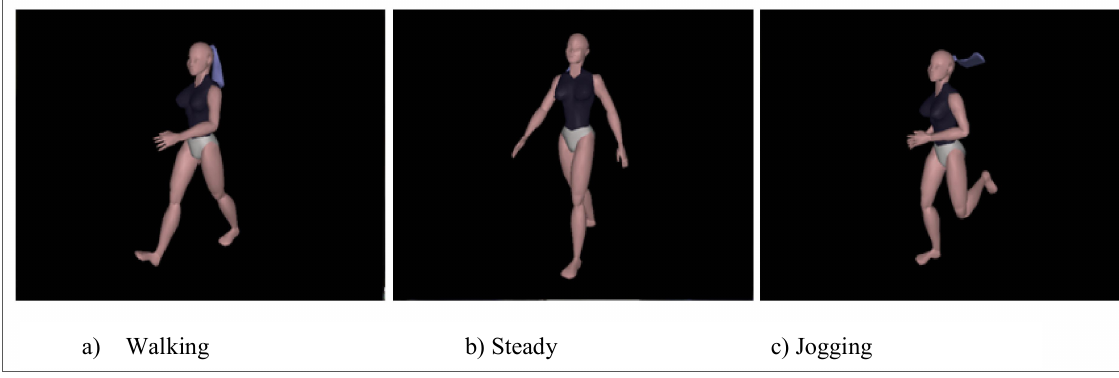
Fig. 5. Character animation: walking, steady and